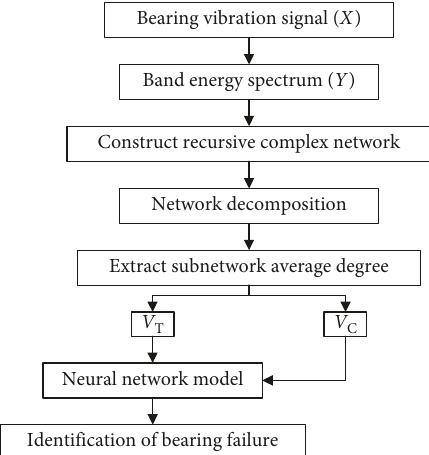
Figure 2: Flowchart for the bearing fault diagnosis based on subnetwork average degree.